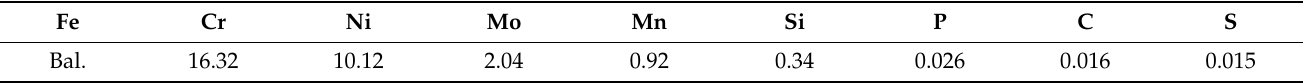
Table 2. Chemical composition of AISI 316L stainless steel substrate (wt.%).